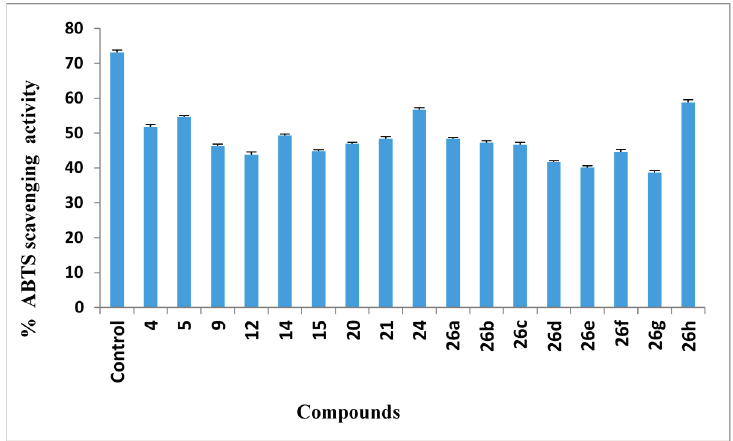
Figure 3. Antioxidant activities of compounds using